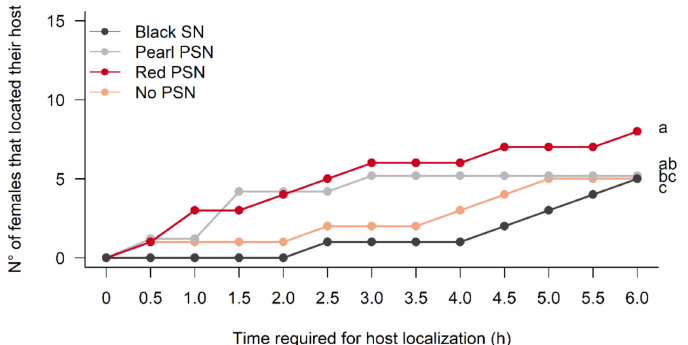
Figure 1. Accumulated number of M. ridens females that located the fifth-instar C. pomonella larvae under the PSN and black SN within the first six hours of observation. Different letters next to each line indicate significant differences among treatments according to the glm test. The significance of each letter is as follows: red PSN (a), pearl PSN (ab), no PSN (bc), and black PSN (c).